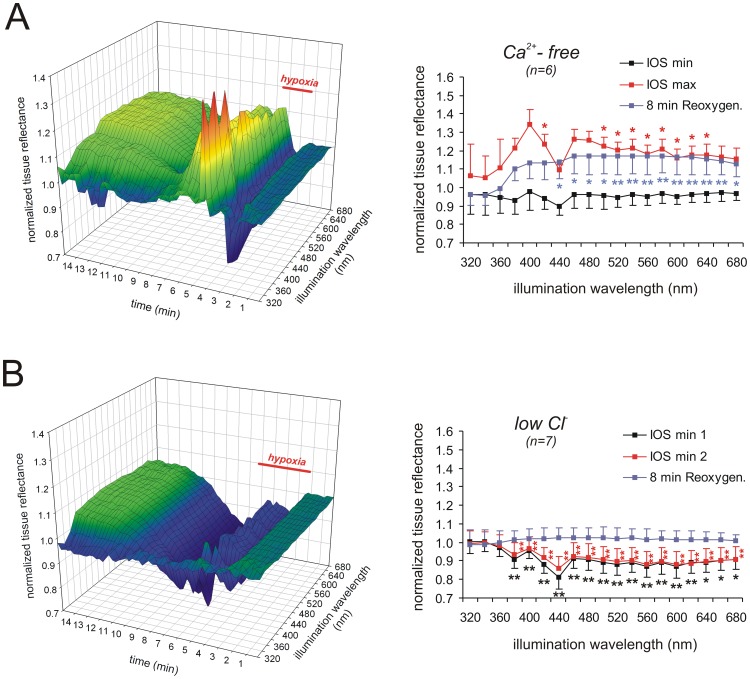
Ca2+-withdrawal intensifies, whereas Cl–replacement reverses the IOS. A) Withdrawal of extracellular Ca2+ intensified the reflectance increase over large parts of the wavelength range during HSD and the posthypoxic recovery. Note that upon reoxygenation tissue reflectance recovered and was then followed by an irreversible secondary reflectance increase, suggesting dendritic damage. B) Near-complete replacement of Cl− distorted the multispectral IOS. Instead of a reflectance increase HSD was now accompanied by a pronounced reflectance decrease. Nevertheless, a secondary reflectance increase occurred during posthypoxic recovery.